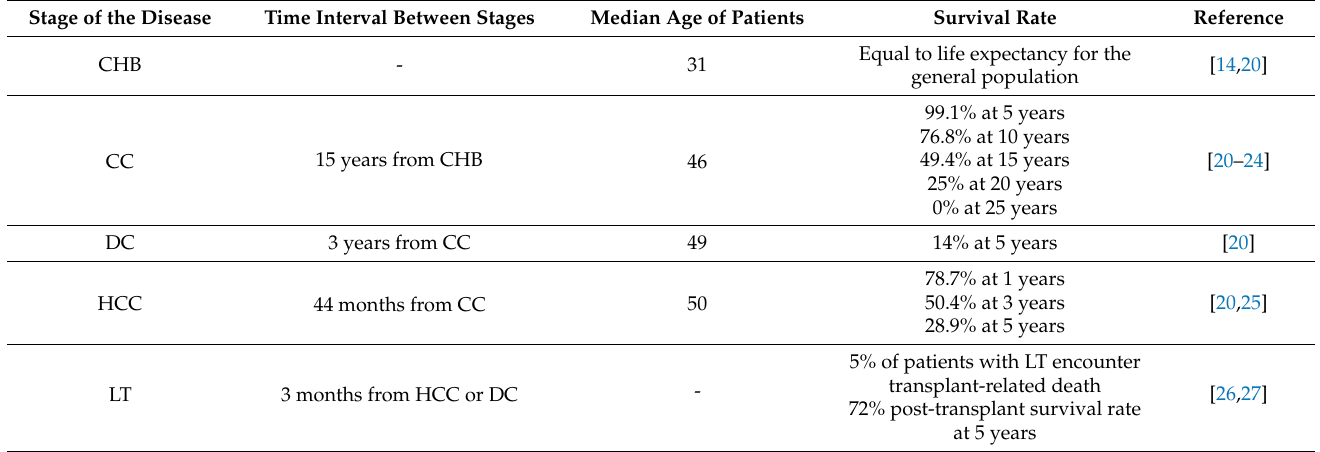
Table 1. Assumed data used for the model (AHB: Acute Hepatitis B; CHB: Chronic Hepatitis B; CC: Compensated Cirrhosis; DC: Decompensated Cirrhosis; HCC: Hepatocellular Carcinoma; LT: Liver Transplantation).